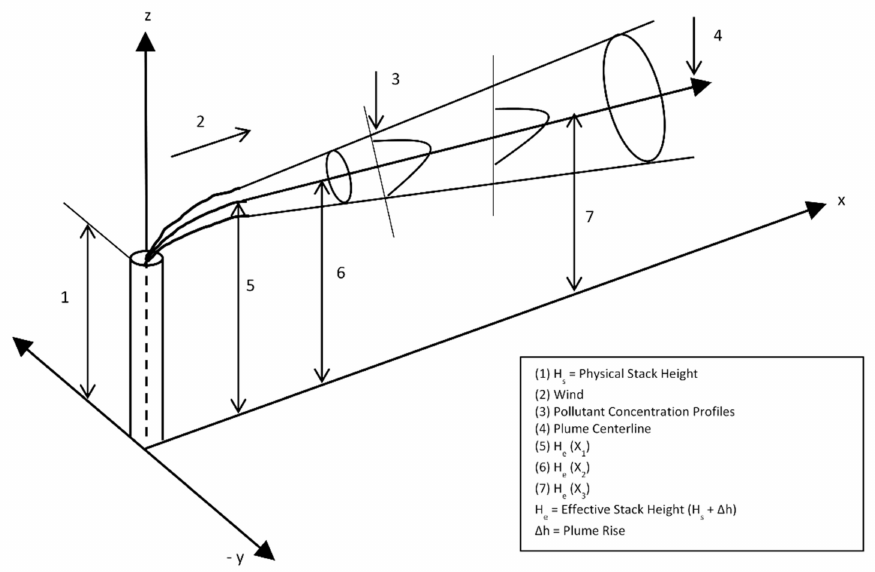
Figure 1. Gaussian dispersion model